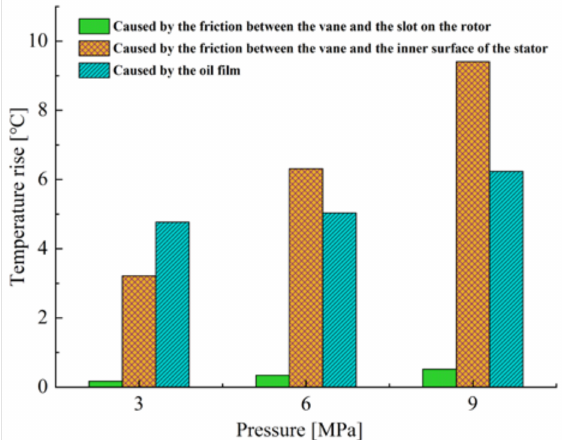
Figure 12. Comparison of the temperature rise of the oil caused by the heat sources in the three parts of the oil suction region.